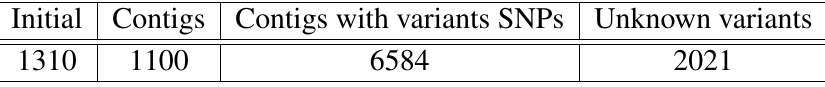
Table 1: Detected variants during the knowledge